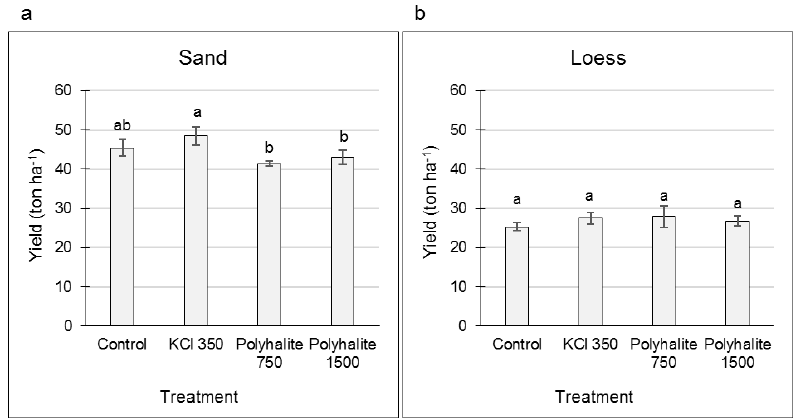
Figure 2. Yields (ton ha −1 ) of sweet potato storage roots following application of the fertilizers KCl at 350 kg ha −1 , or polyhalite at 750 or 1500 kg ha −1 . Plants were grown in sandy ( a ) or loess soil ( b ). Values are average of six replicates with SE. Data were analyzed for statistical significance between means of the different treatments by Student’s t -test. Values followed by different letters are significantly different ( p < 0.05).